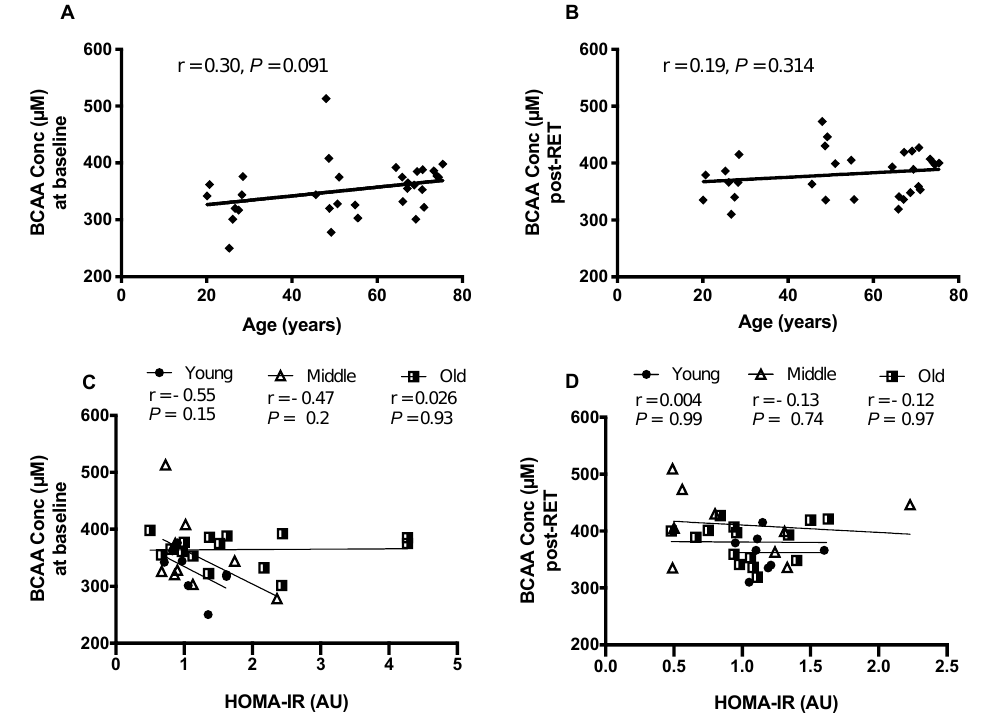
Figure 1. The relationship between circulating branched chain amino acid (BCAA) concentrations and age at baseline ( A ) and after ( B ) 20 weeks of supervised, whole-body resistance exercise training (RET) ( n = 8 – 15/ group) and in distinct age groups at baseline ( C ) and after RET ( D ).